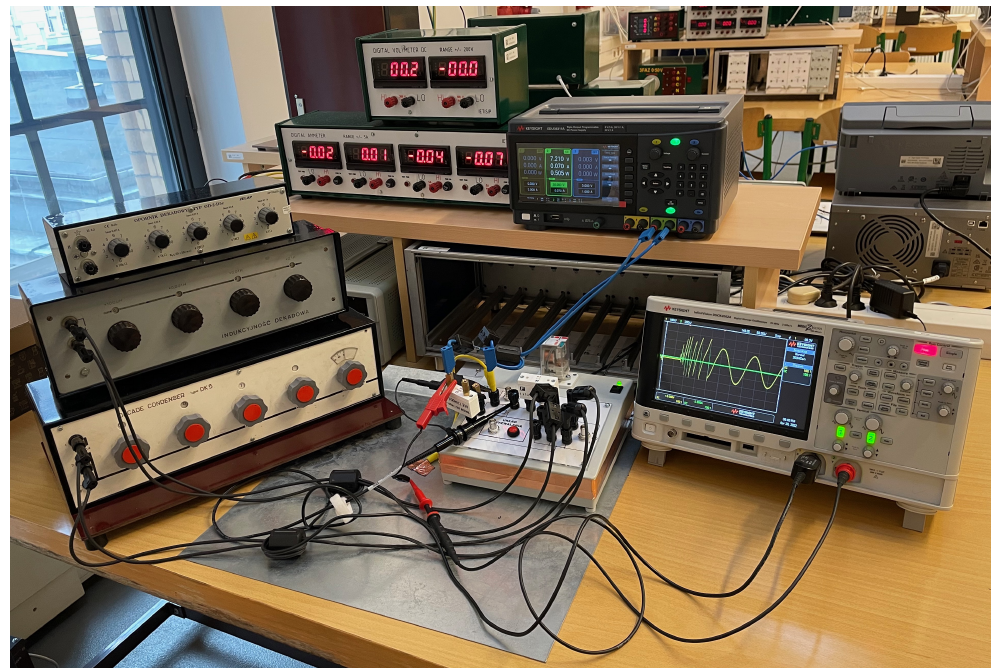
Figure 1. Research